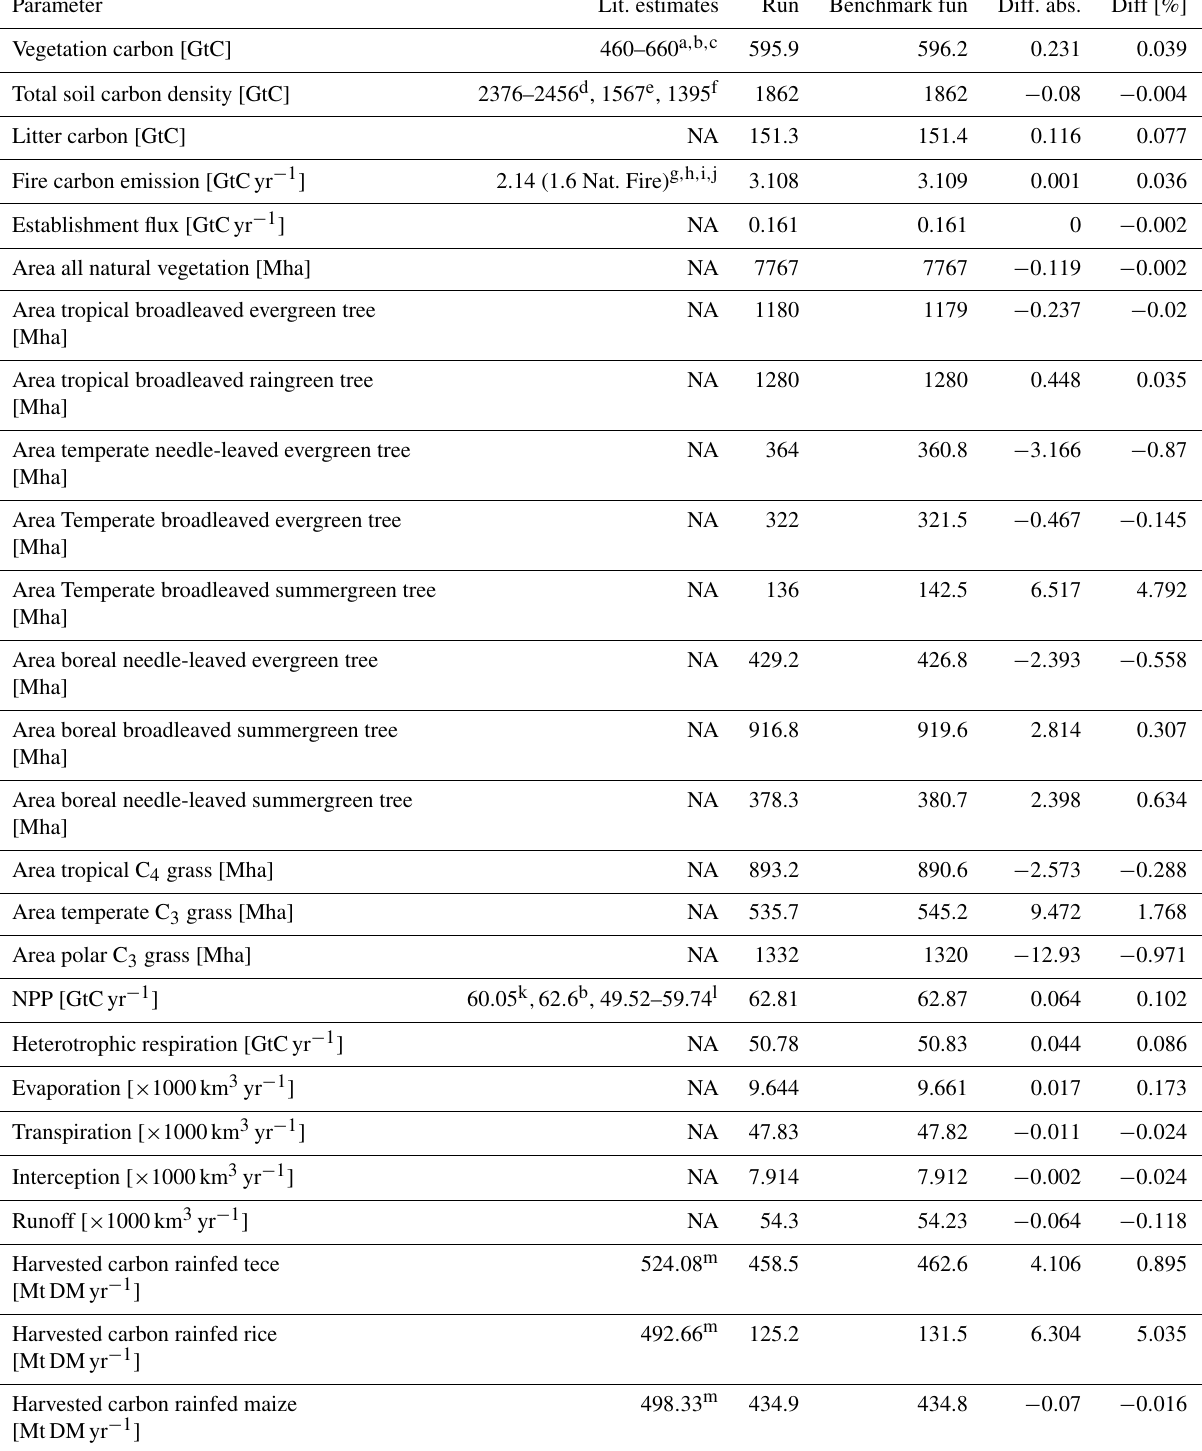
Table C1. Global sums of actual vegetation, including land-use, comparing Newton approach (benchmark run) against bisection approach (run). Tece is temperate cereals. NA – not applicable, Mha – megahectare, Mt DM – megatonnes of dry